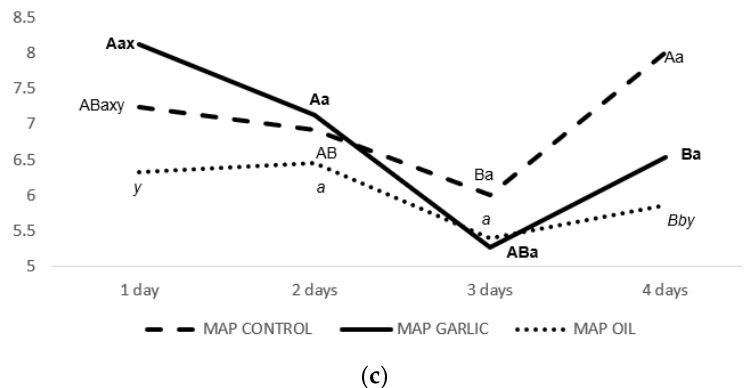
Figure 1. Visual appraisal scores of pork meat in function of PDE feed-addition, exposure time and packaging type. ( a ) Film packaging; ( b ) vacuum packaging; ( c ) MAP (modified atmosphere) packaging). a,b. Different letters means statistical differences ( p < 0.05) between packaging types inside PDE group and exposure time. A,B. Different letters means statistical differences ( p < 0.05) between exposure time inside PDE group and packaging type. x,y. Different letters mean statistical differences ( p < 0.05) between PDE groups inside packaging type and exposure time. Bold letters-garlic group. Italics -oil group.